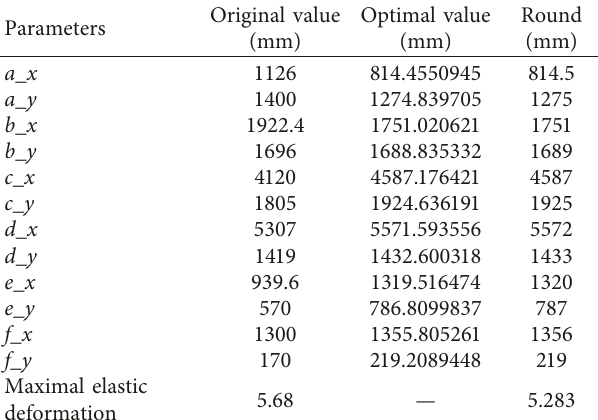
Table 7: Optimized design